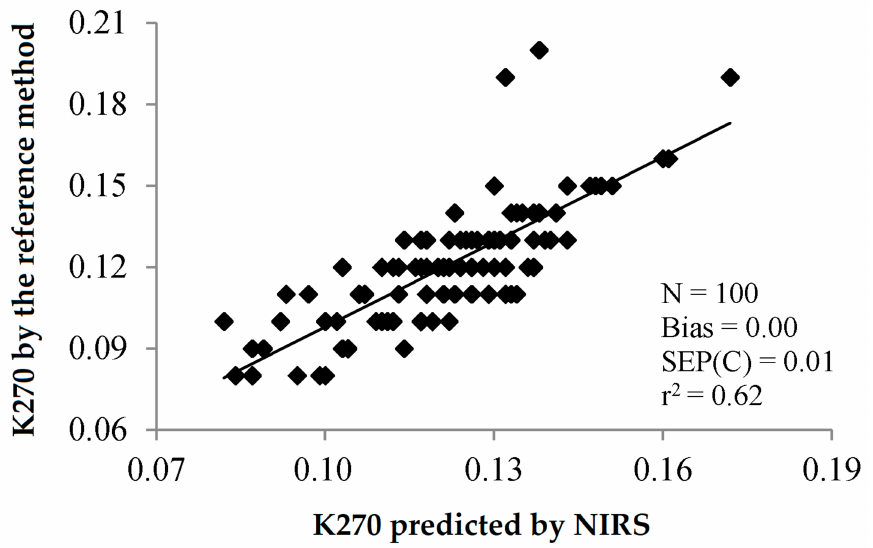
Figure 12. Validation exercise for the determination of K270 of olive oil by PLS-NIRS using all the wavelengths between 400 and 2500 nm